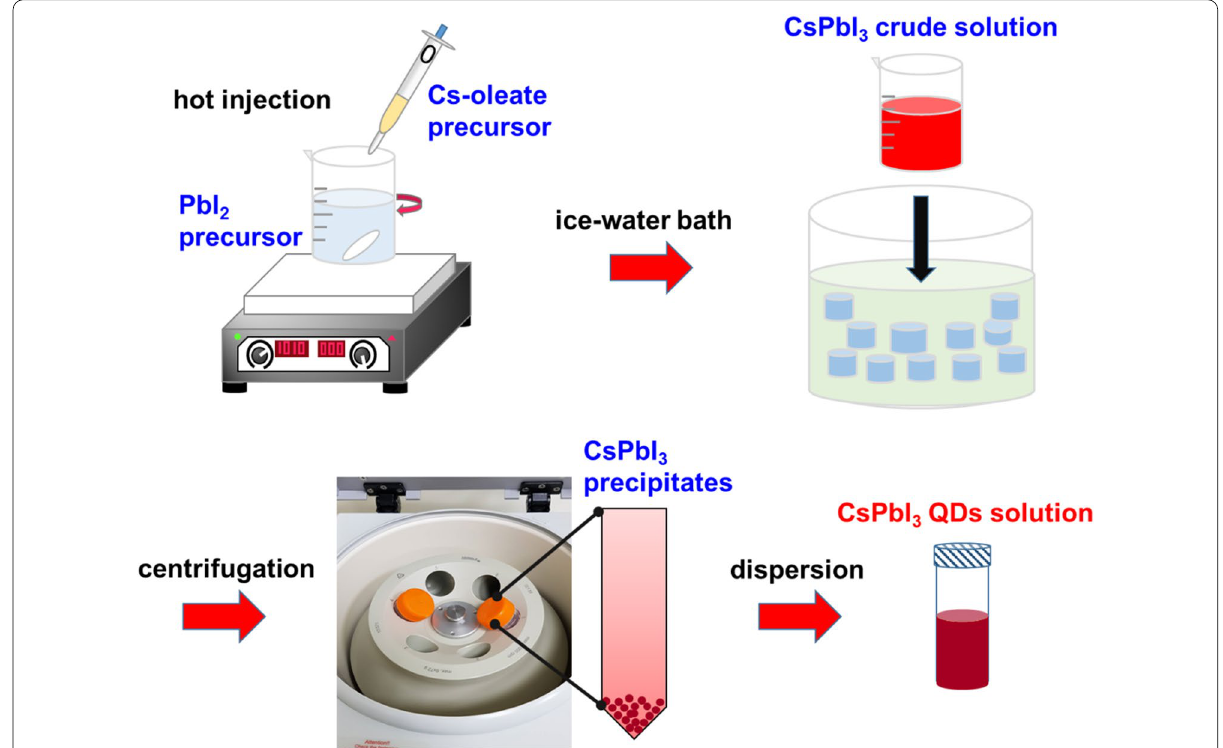
Fig. 1 Schematic representation of the synthesis of perovskite CsPbI 3 QDs via hot‑injection and ice water bath methods